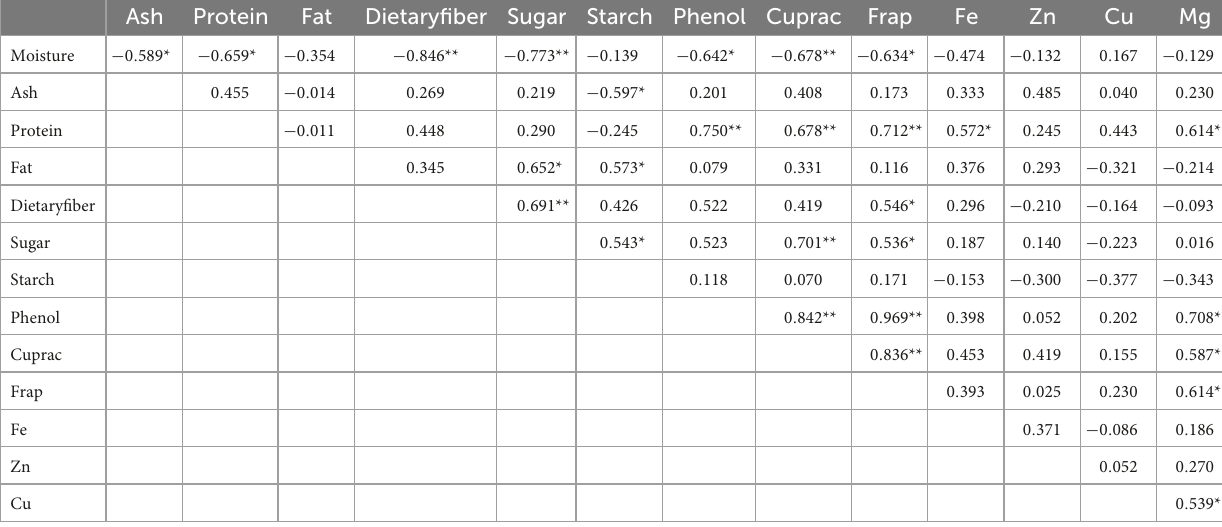
*Correlationissignificantatthe0.05level(2-tailed).**Correlationissignificantatthe0.01level(2-tailed). is reported on a fresh weight basis in the range of 3–4% (43,